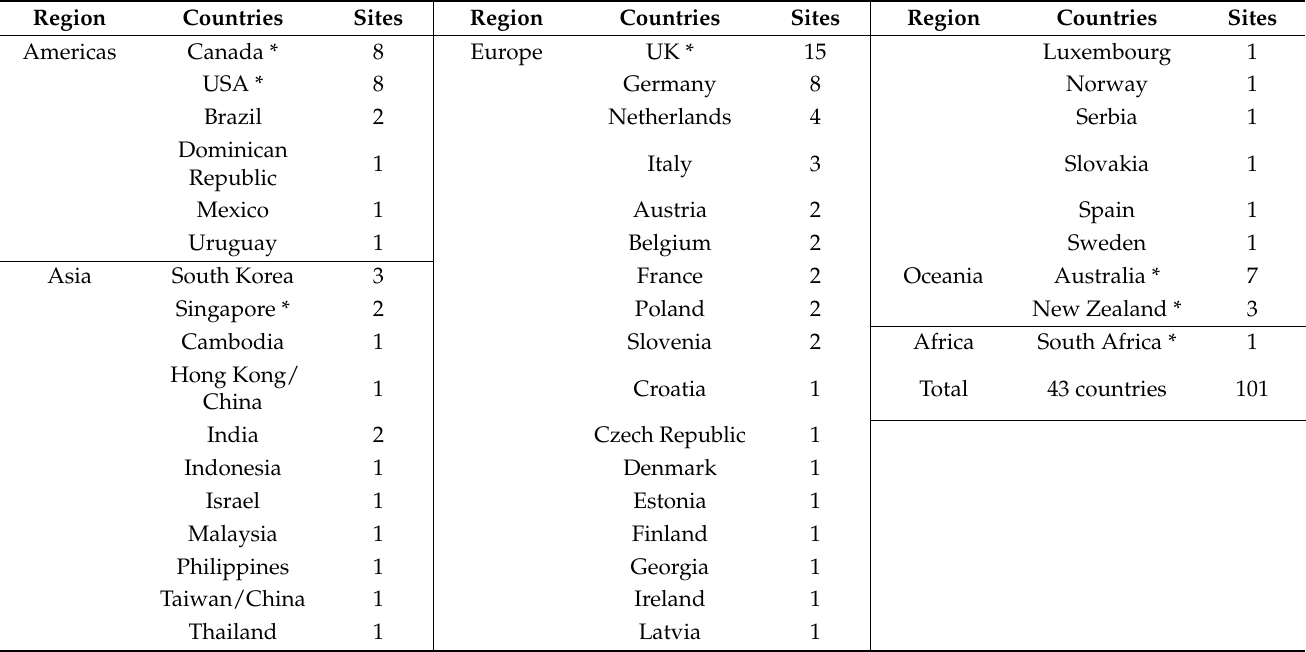
Table 1. Number of countries and cases where urban beekeeping has been confirmed to exist. “*” Indicates seven extracted countries. In addition to Japan, eight countries were selected for the survey. Region Countries Sites Region Countries Sites Region Sites Americas